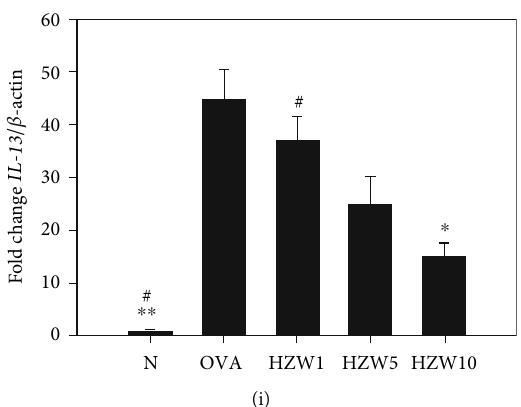
Figure 9: E ff ects of HZW on gene expression of cytokines, chemokines, and in fl ammatory mediators in the lungs. The gene expression levels of COX-2 (a), CCL11 (b), CCL24 (c), ICAM-1 (d), MUC5AC (e), IFN- γ (f), IL-4 (g), IL-5 (h), and IL-13 (i) were determined by real-time PCR of RNA extracted from the lung tissues of normal (N) and OVA-stimulated (OVA) mice, treated with or without HZW. Fold changes in expression were measured relative to β -actin expression (internal control). Data are presented as the mean ± SEM . ∗ P < 0 : 05 and ∗∗ P < 0 : 01 compared with the OVA control group. # P < 0 : 05 and ## P < 0 : 01 compared to the HZW10